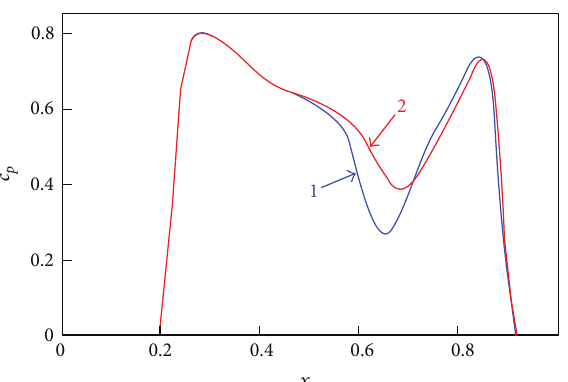
Figure 9: Pressure coefficient 𝑐 𝑝 versus 𝑥 on the upper surface of the swept wing in the midspan section 𝑧 = 1 at 𝛼 = 0 , Re = 5.1 × 10 6 : 1— 𝑀 ∞ = 0.8535, 2— 𝑀 ∞ = 0.8565.